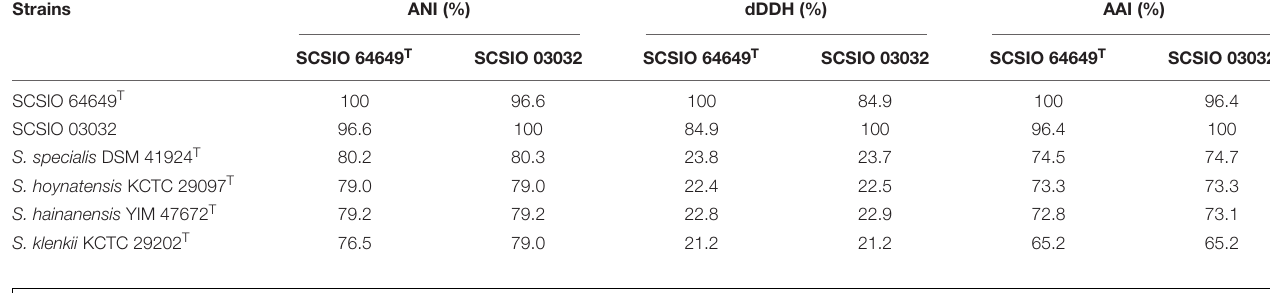
TABLE 1 | ANI, dDDH values, and AAI found between isolates and their closest species. Strains